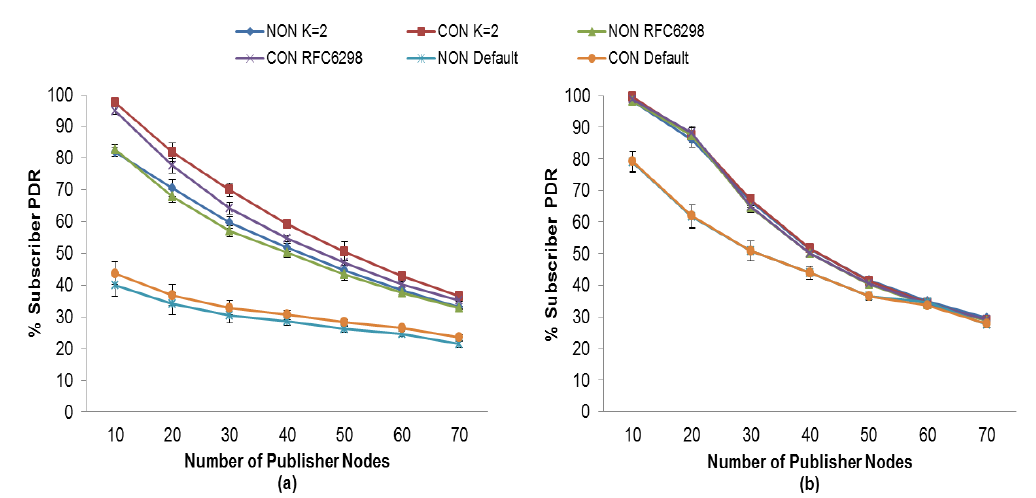
Figure 18. PDR comparisons between the RTO method of MQTT-S calculation and our proposal without ( a ) and with ( b ) MAC